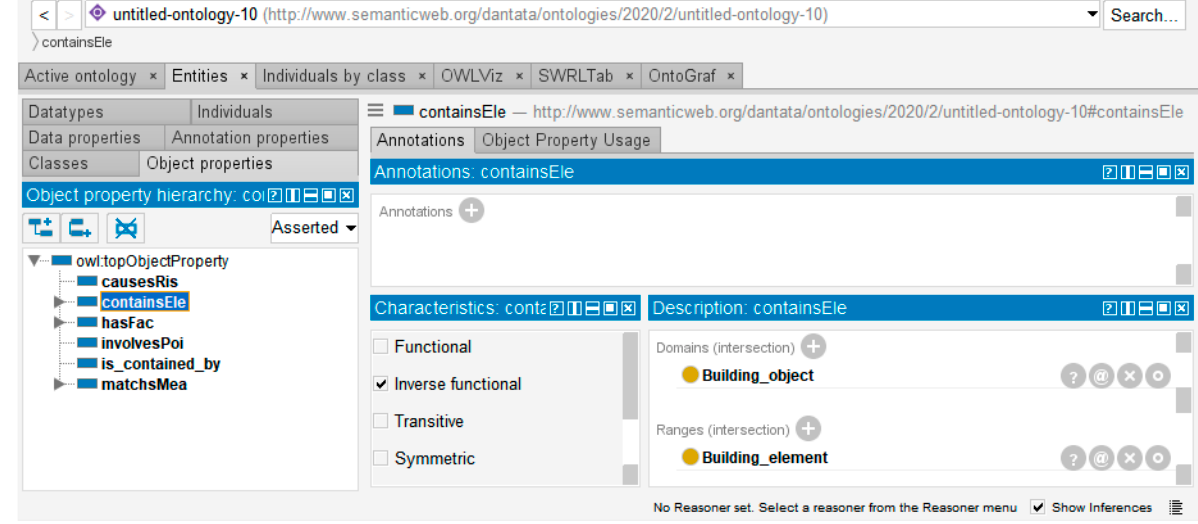
Figure 13. Object properties of DFS ontology in Protégé.